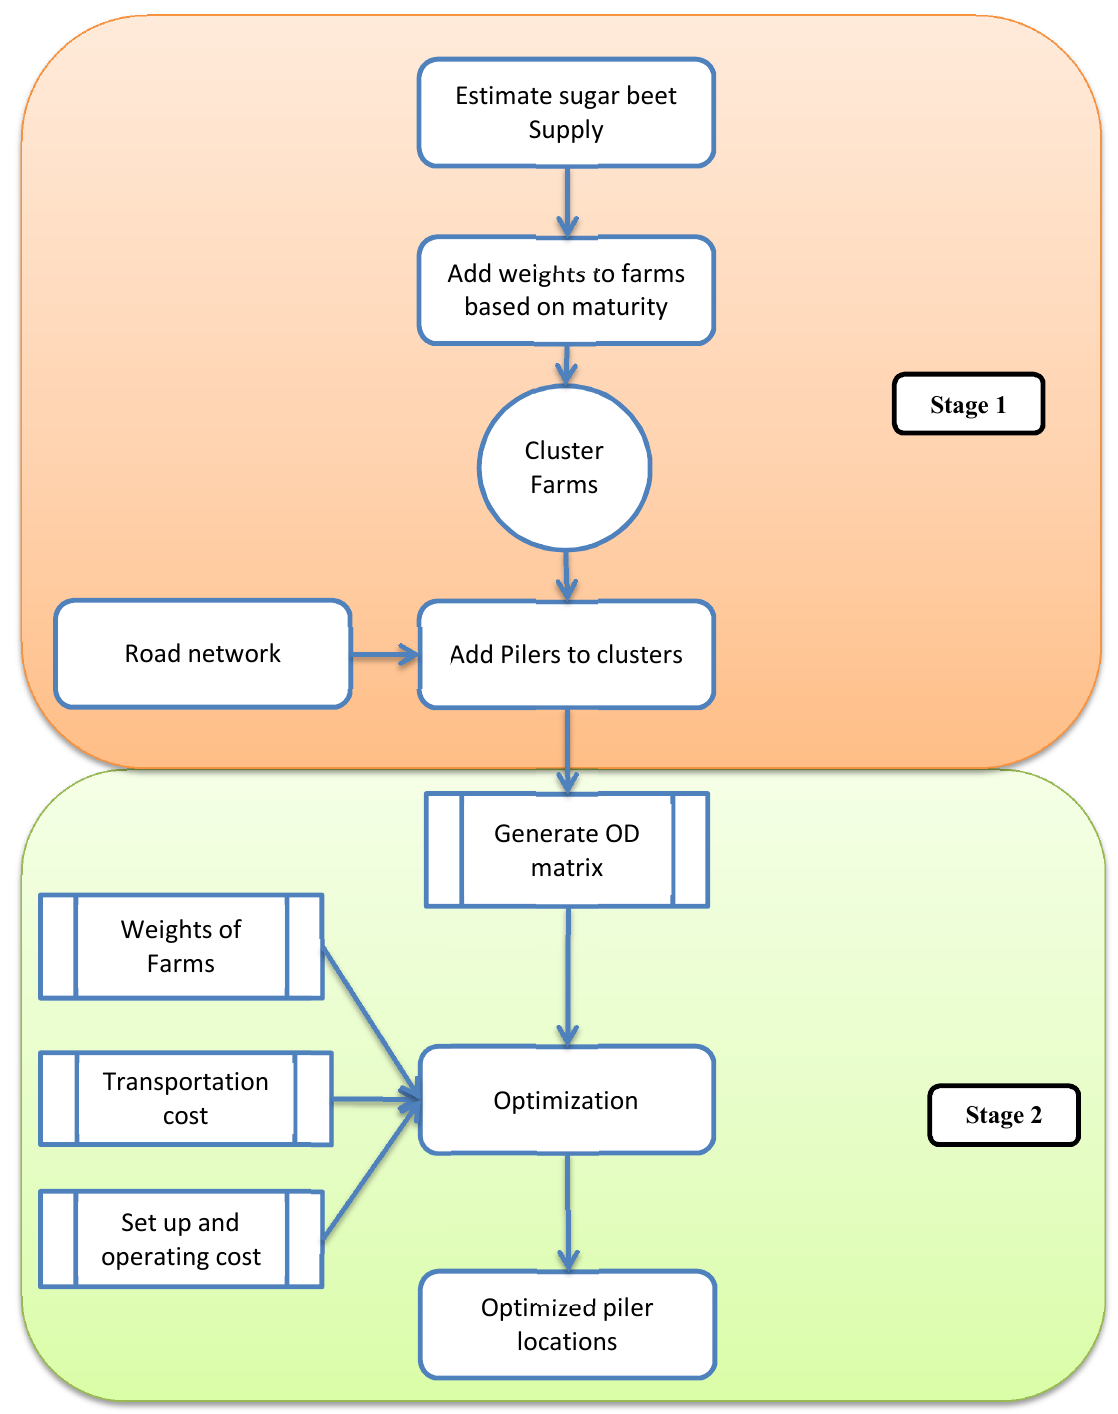
Figure 3. Solution algorithm. O–D: origin–destination.